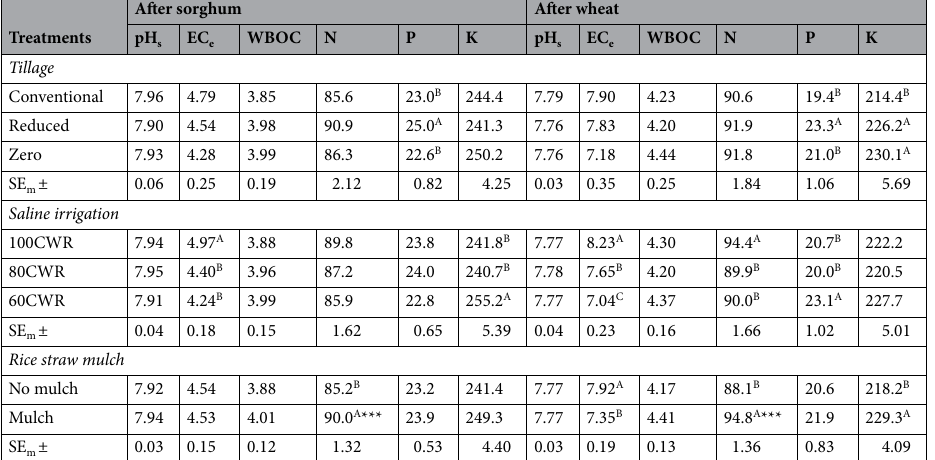
wheat, with associated negative impacts on crop productivity and Sustainable Development Goals related to food security (SDGs 2) in long term 4,7,10 . Sorghum is a moderately salt-tolerant C 4 grass adapted in rainfed semi-arid and arid regions 11 . Its salinity